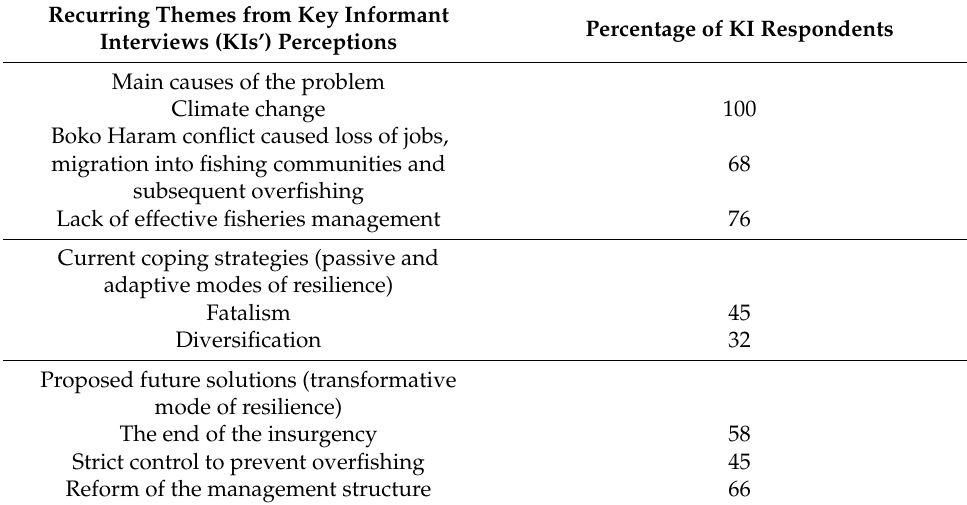
Table 1. Percentage of KI’s perceptions about themes (Source: data collected by authors from the Nigerian shore of Lake